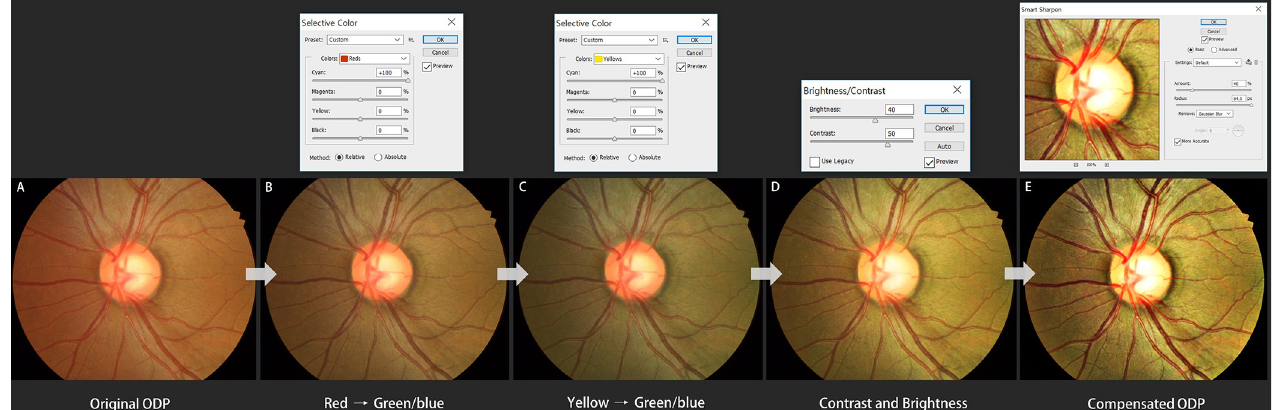
Fig 3. Customized image post-processing algorithm for maximized visibility of hemorrhage. (A) Original ODP. (B) With Selective color tool, red color was replaced by green/blue and (C) yellow was replaced by green/blue. (D) With the Contrast/Brightness tool, the contrast level was improved, and with the Smarten sharpen tool, the degree and range of the sharpness was increased. (E) Finally, a compensated high-resolution ODP could be obtained.